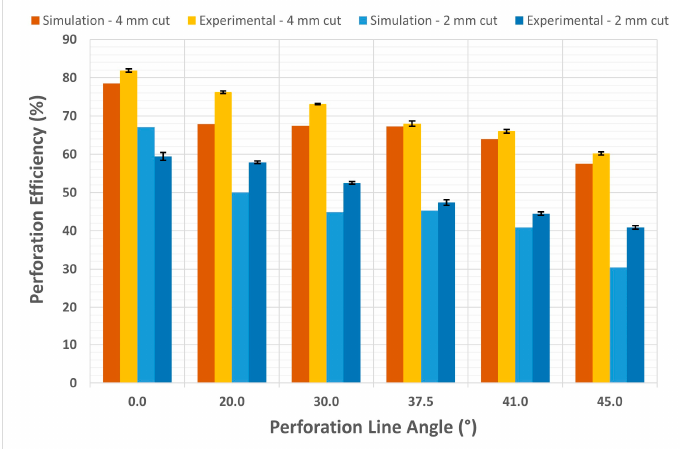
Figure 5 . Perforation efficiency behavior as function of perforation line angle . Figure 5. Perforation efficiency behavior as function of perforation line angle.